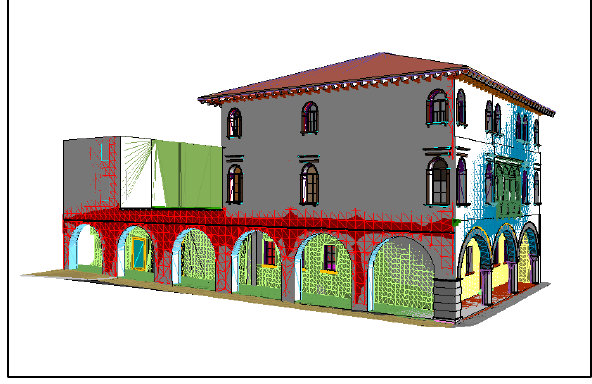
Figure 14. Fusion of Advanced 3D and BIM models.